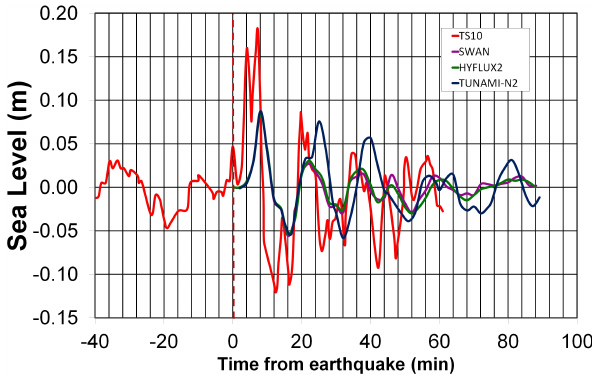
Fig. 17. Time series of sea level elevation from model forecasts for the earthquake compared to TS10.